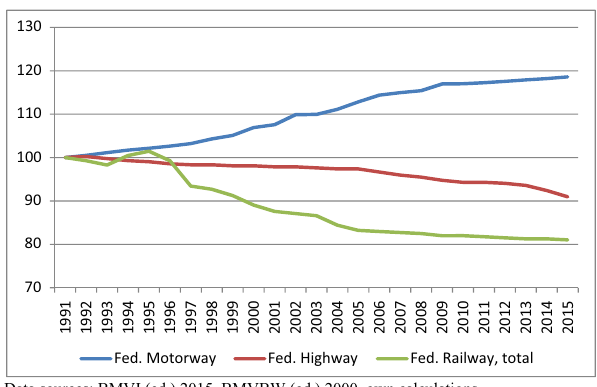
Fig. 1 Development offederal motorway, highway, and railway network length, 1991 – 2015 (1991 =